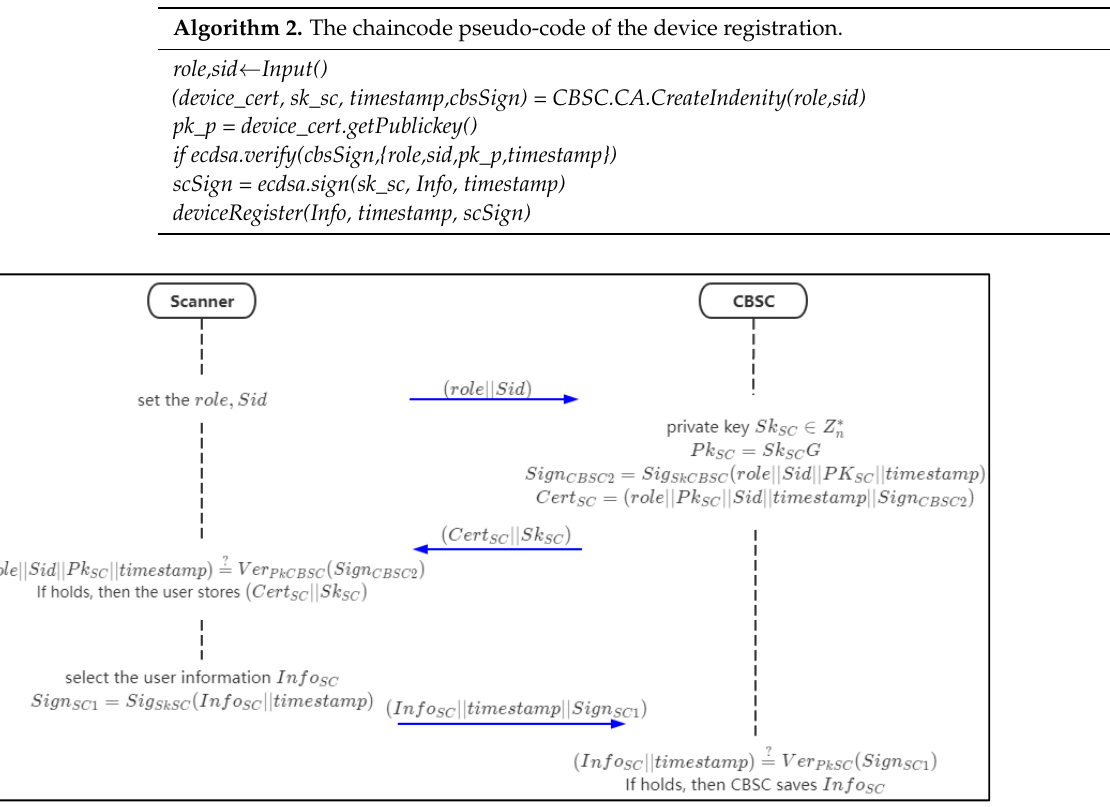
Figure 7. The flow chart of scanner device registration.